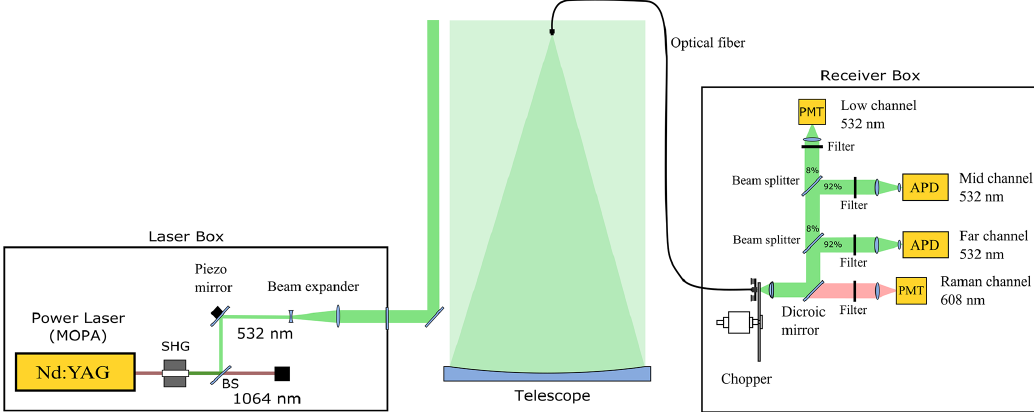
Figure 2. Schematics of the lidar instrument and optical paths.